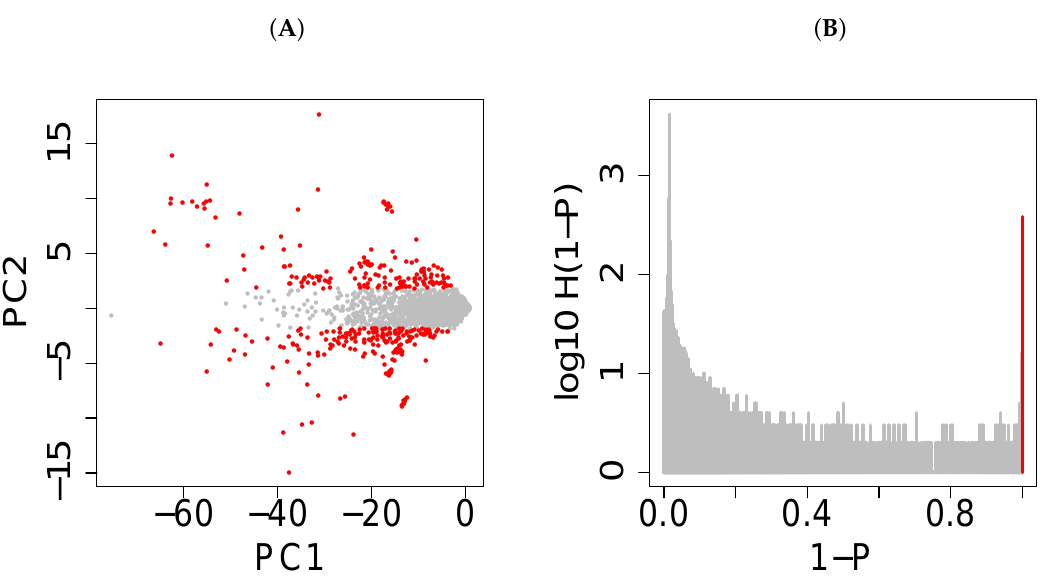
Figure 4. ( A ) The scatter plot of x (cid:96) , (cid:96) 1 = 1 ( horizontal axis ) ,2 ( vertical axis ) for GSE26996; 379 red 1 , i dots are selected probes; and ( B ) a semilogarithmic plot of the histogram of 1 − P under the null hypothesis that x (cid:96) obeys a normal distribution. A sharp peak is observed in the red bin with the 1 = 2, i largest 1 − P , which includes all the probes selected in ( A